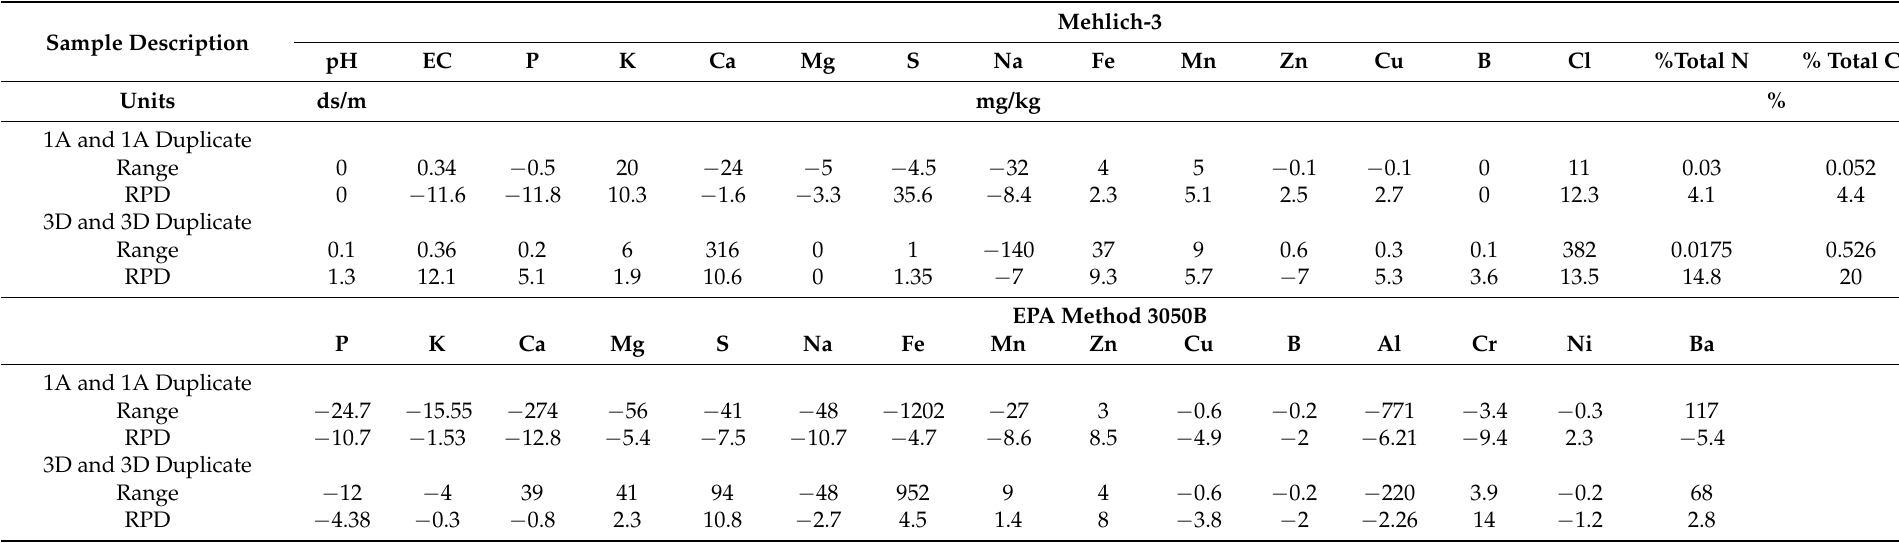
Table 6. Fields 1, 2, and 3 soil sample and duplicate range and Relative Percent Difference (RPD). Soil Sample nutrient data from the research